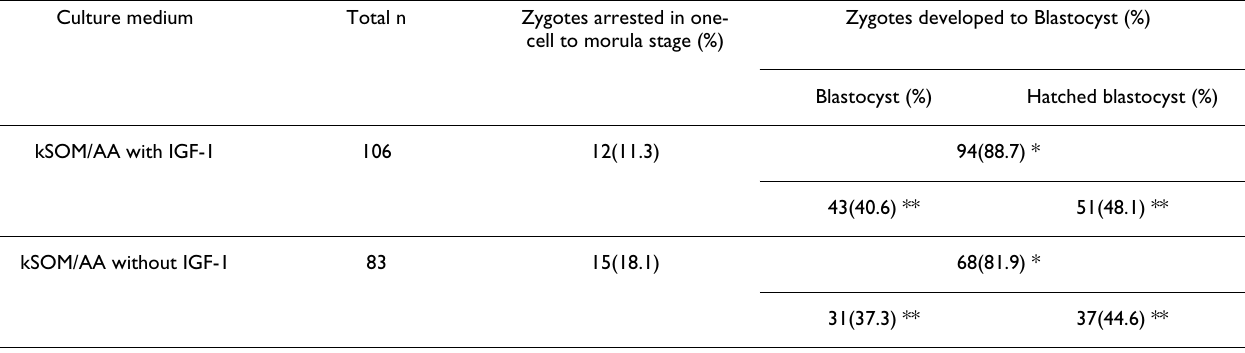
Table 1: The effect of IGF-1 upon the developmental competence of in vivo fertilized mouse zygotes. Culture